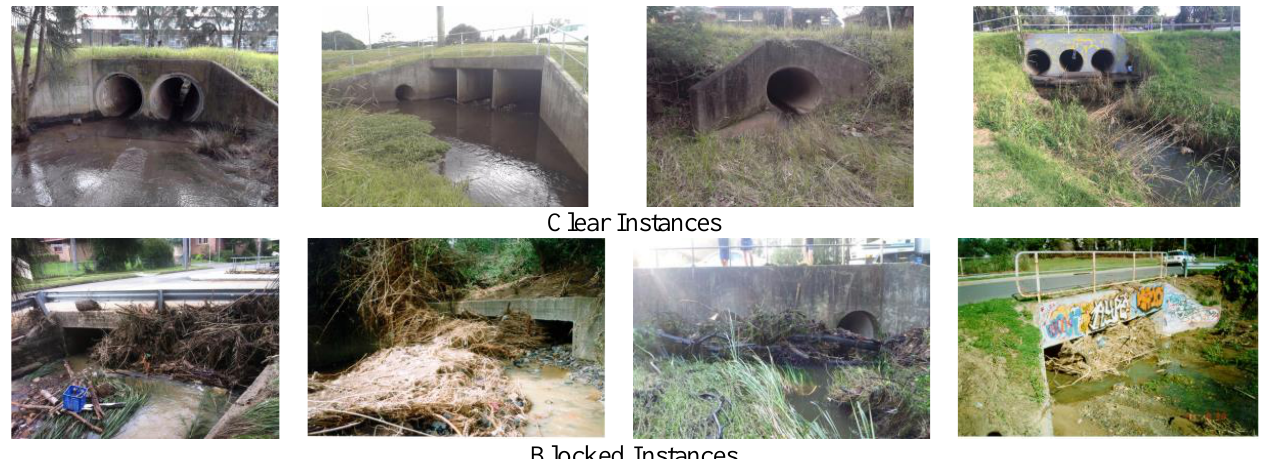
Figure 1. Sample instances of clear (First row) and blocked (Second row) culverts from